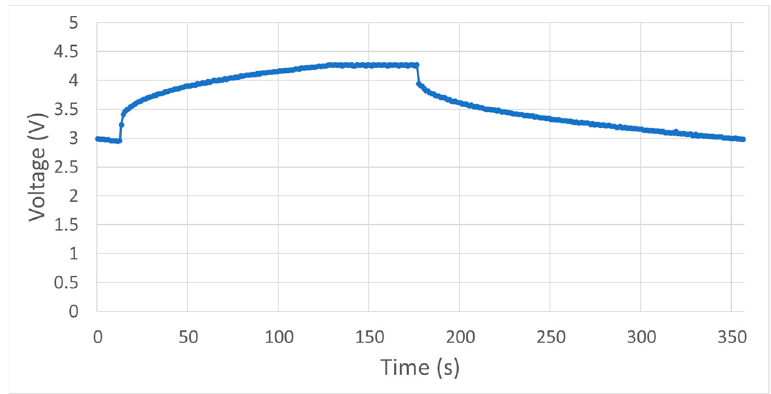
Figure 3. Supercapacitor test.